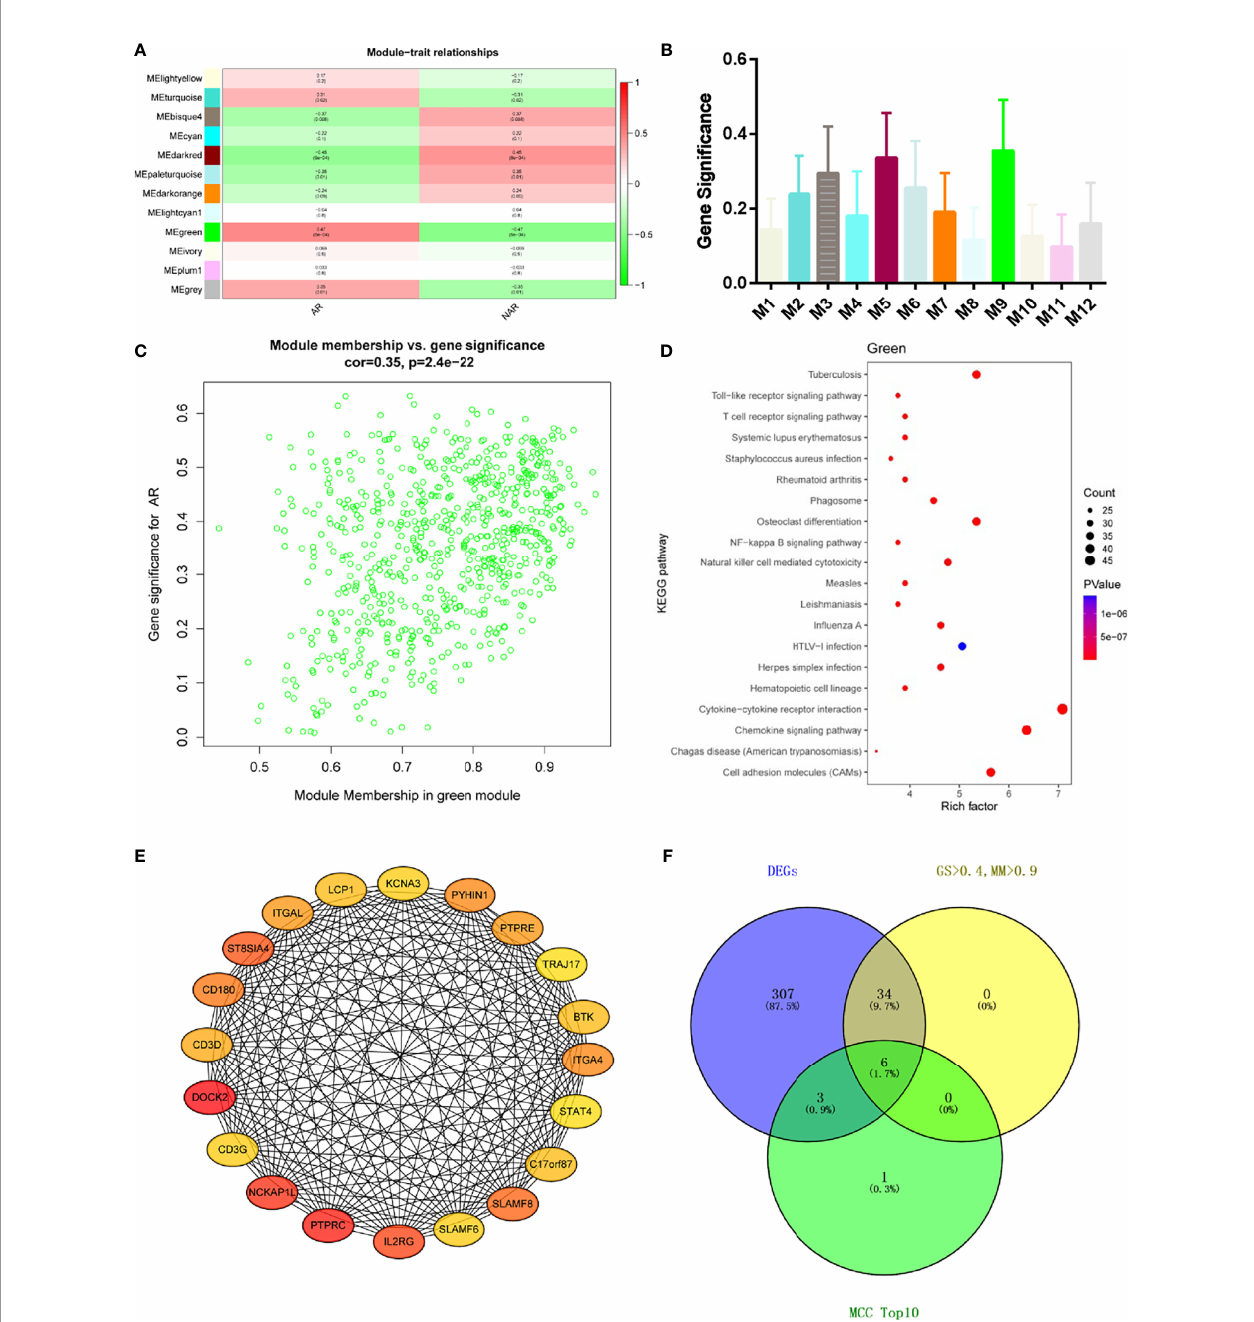
FIGURE 3 | WGCNA revealed gene co-expression networks and the key genes in the percutaneous allograft biopsy of 15 AR patients. (A) Heatmap of the correlation between the module eigengenes and clinical traits of AR. We selected the green block for subsequent analysis. (B) Module signi fi cance values of those co-expression modules associated with SS (module signi fi cance value indicated the summary of gene signi fi cance of all genes in each module, and different colors of column indicated different modules). (C) The gene signi fi cance for AR in the green module (one dot represents one gene). (D) Top 20 pathways from Kyoto Encyclopedia of Genes and Genomes enrichment analysis. The x-axis represents KEGG enrichment scores, and the y-axis represents pathway terms. The colors of circle indicate p -values, and the size of circle indicates the numbers of differential RNAs. The redder and larger circle indicates that the enrichment of the pathway is higher and differential RNAs number is larger in the pathway. (E) Interaction of gene co-expression patterns in the green module. Each node corresponds to a gene. Colors from yellow to red correspond to the top 10 maximal clique centrality (MCC) values from low to high. (F) Identi fi cation of the hub gene in the intersection of MCC TOP10, DEGs, and GS > 0.4, and MM >